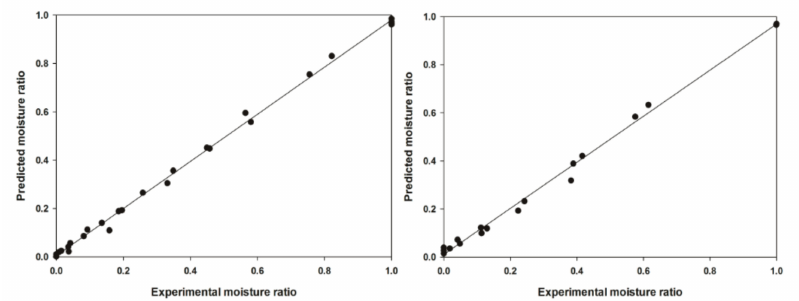
Figure 7. Predicted and experimental moisture ratio using HAD from training and testing data set of ANN.